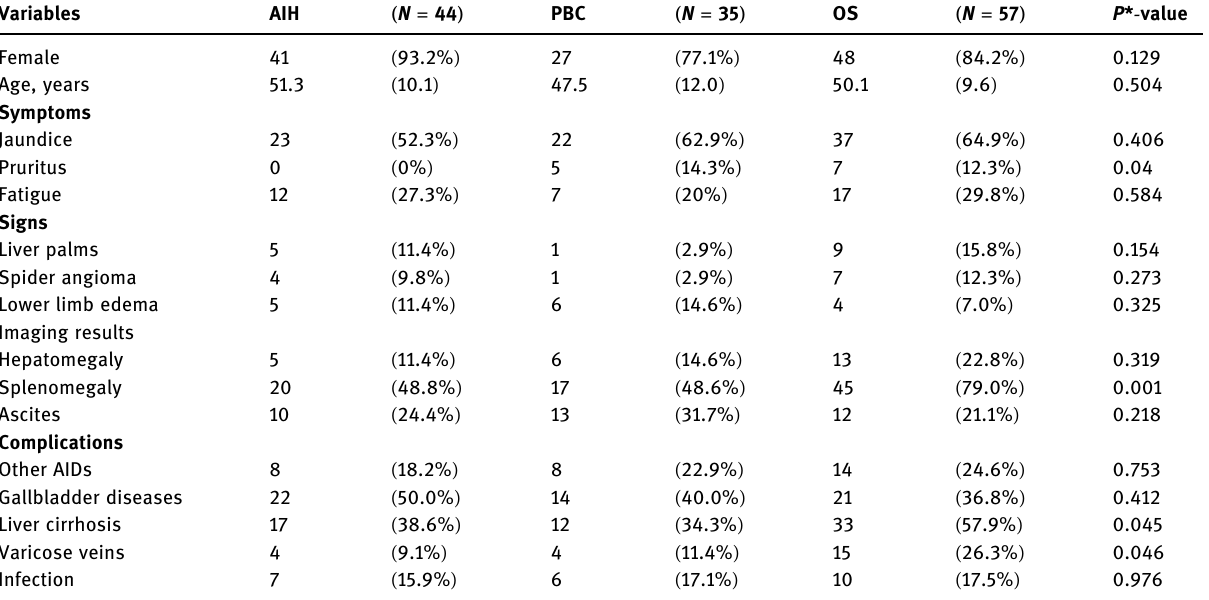
Table 1: Demographic characteristics of study